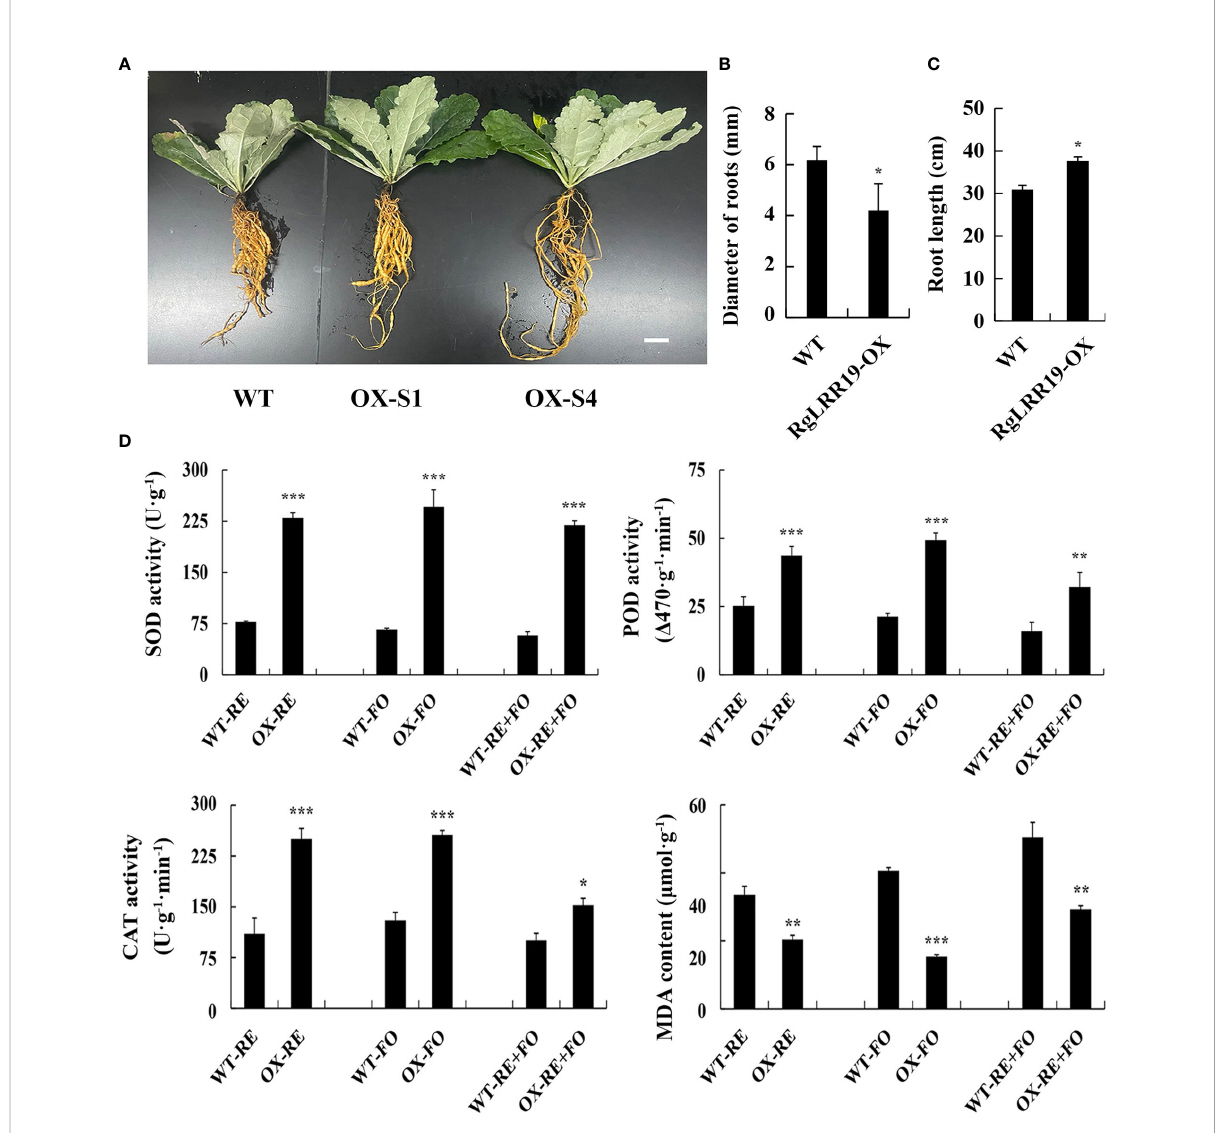
FIGURE 8 RgLRR29- overexpression improves plant resistance against root exudates, F. oxysporum and comprehensive stress of root exudates and F. oxysporum. (A – C) , Phenotypic analysis of the WT and transgenic lines. Bar = 2 cm. (D) Changes of physiological indexes in WT and RgLRR29 - overexpression Rehmannia glutinosa plants under the treatments of root exudates, F. oxysporum and comprehensive stress of root exudates and F. oxysporum . RE, the treatment of root exudates; FO, the treatment of F. oxysporum ; RE+FO, the comprehensive treatment of root exudates and F. oxysporum . The error bars represent the standard error (n = 3) (*: p < 0.05; **: p < 0.01; ***: p <